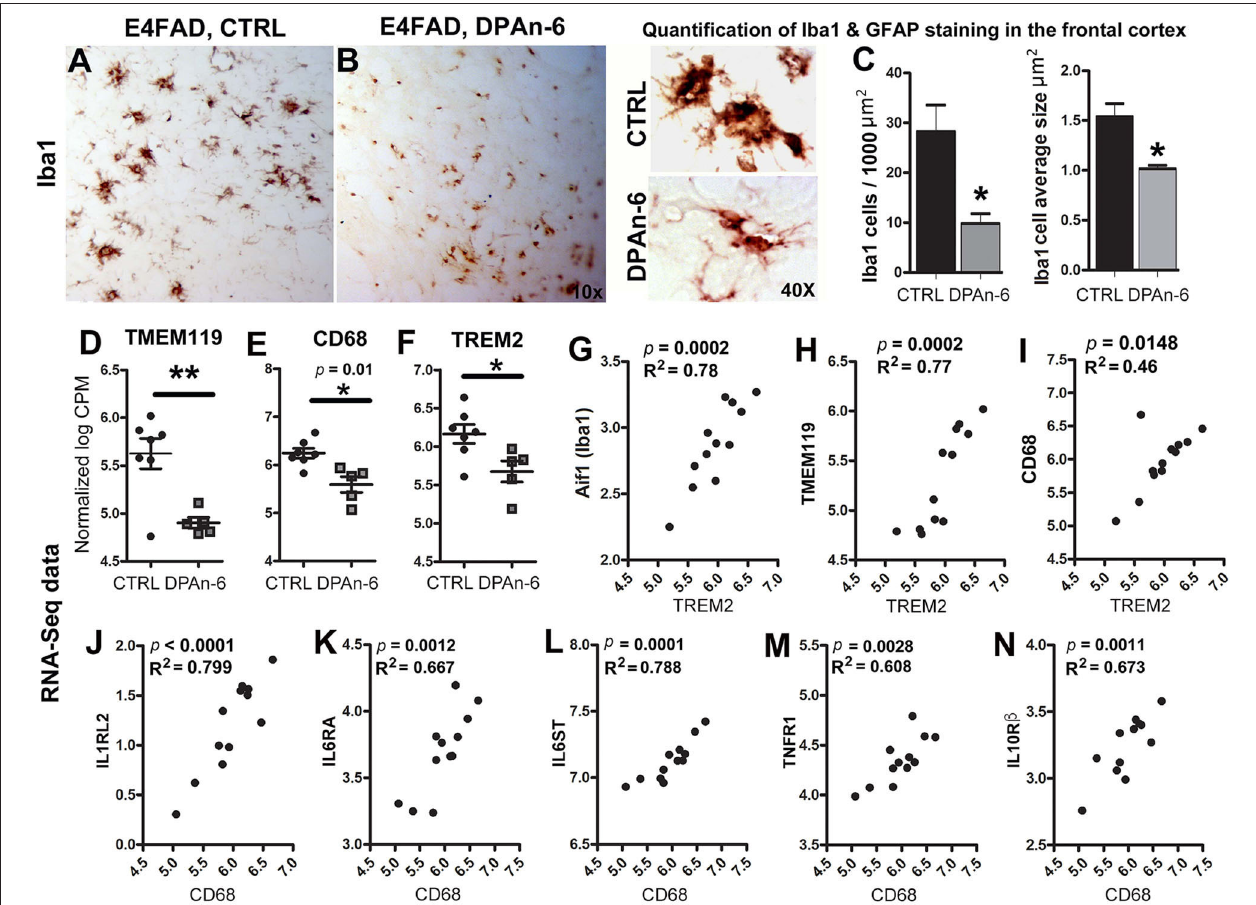
FIGURE 3 | DPAn-6 attenuated microgliosis and reduced mRNA expression of microglial markers in aged E4FAD mice. (A,B) Immunostaining for the microglial marker Iba1 showed that DPAn-6 altered microglia morphology from an overactive hypertrophied shape to small ramified cell shape. (C) Quantification showed reduction of numbers of hypertrophied microglia and cellular size of activated microglia by DPAn-6 ( p < 0.05). (D–F) DPAn-6 suppressed microglial gene expressions of TMEM119 ( p < 0.01 , D ), CD68 ( p = 0.01 , E ), and TREM2 ( p < 0.05 , F ) compared to controls (CTRL) on standard diet. (G–I) TREM2 was positively correlated with Iba1 (Aif1, p = 0.0002, R 2 = 0.78, G ), TMEM119 ( p = 0.0002, R 2 = 0.77, H ), and CD68 ( p = 0.0148, R 2 = 0.46, I). (J–N) Activated microglial marker CD68 was positively corelated with IL1RL2 ( p < 0.0001, R 2 = 0.799, J ), IL6RA ( p = 0.0012, R 2 = 0.667, K ), IL6ST ( p = 0.0001, R 2 = 0.788, L ), TNFR1 ( p = 0.0028, R 2 = 0.608, M ), IL10Rß ( p = 0.0011, R 2 = 0.673, N ). The RNA-Seq data were normalized by Count Per Million (CPM) and presented as Log2 expression. Data represents the mean ± SEM. Significance was determined using an unpaired, two-tailed Student’s t -test, * p < 0.05, and ** p <